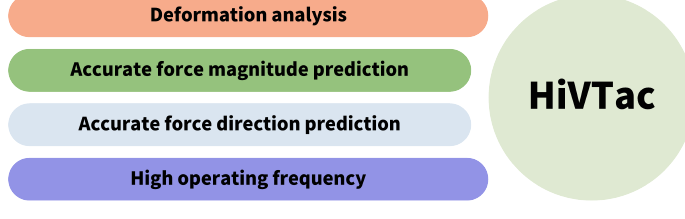
Figure 2. Key advances of this